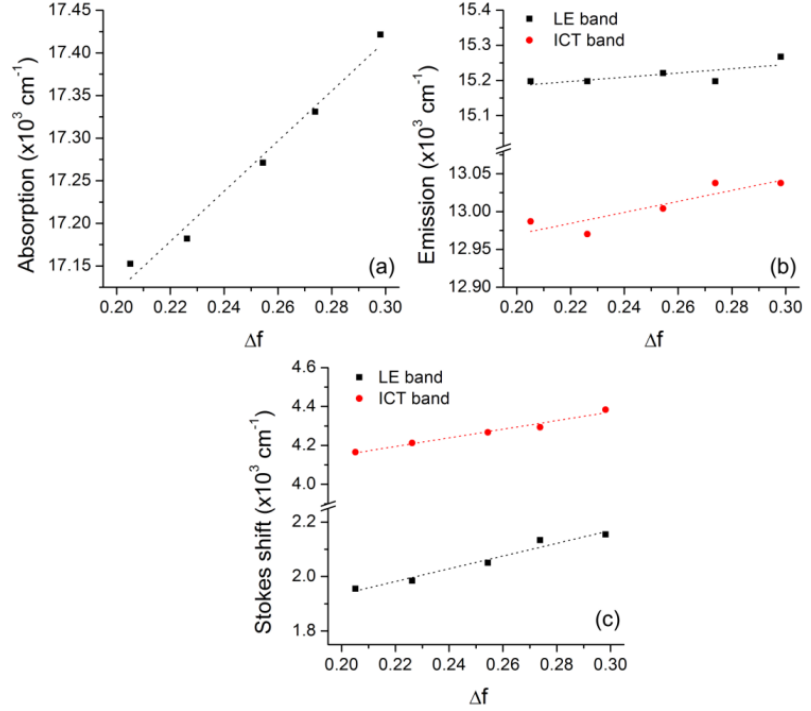
Figure 4. Solvent effect on the spectral position of the ( a ) absorption, ( b ) fluorescence emission maxima at LE and ICT bands, and respective ( c ) Stokes shift for cyanine dye 8b in different acetonitrile/1,4-dioxane mixtures.